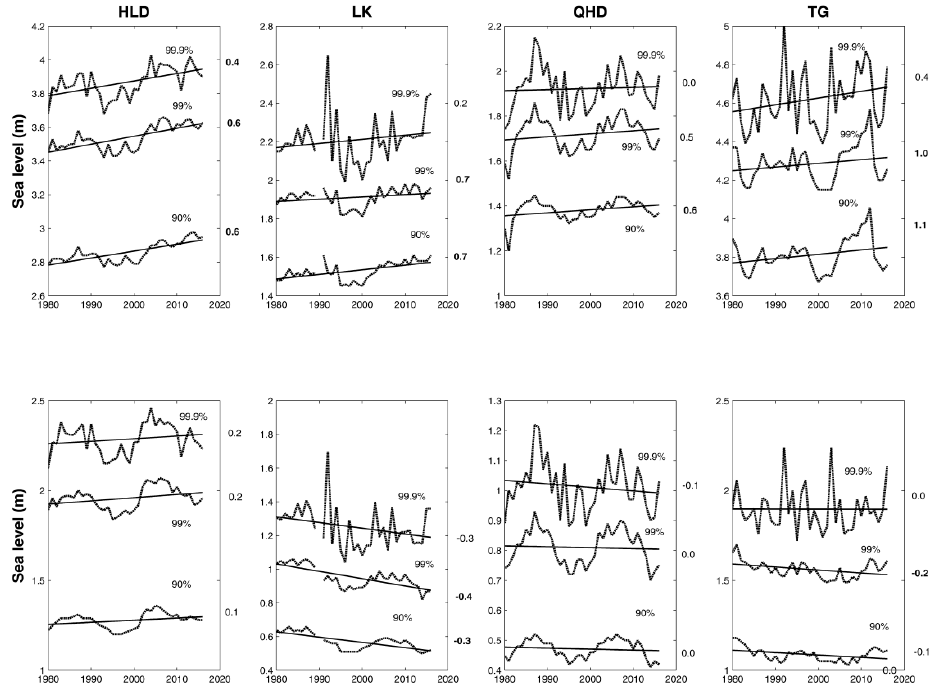
Figure 10. Time series of percentiles of total ( top ) and reduced ( bottom ) sea level for HLD, LK, QHD and TG; the straight lines are the linear trends, and their change rates (cm/year) are listed at right of the figure (in bold if significant at 95%).